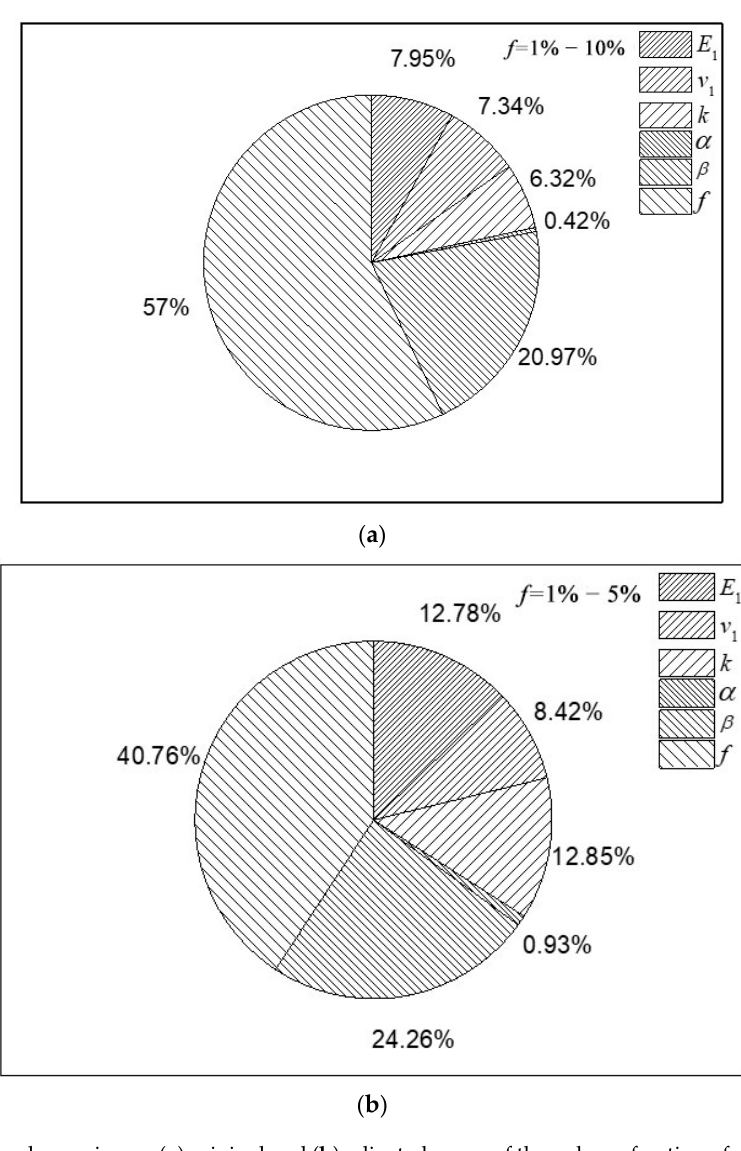
Figure 9. FSI values using an ( a ) original and ( b ) adjusted range of the volume fraction of microcapsules for the C30 concretes with the bulk modulus objective function.